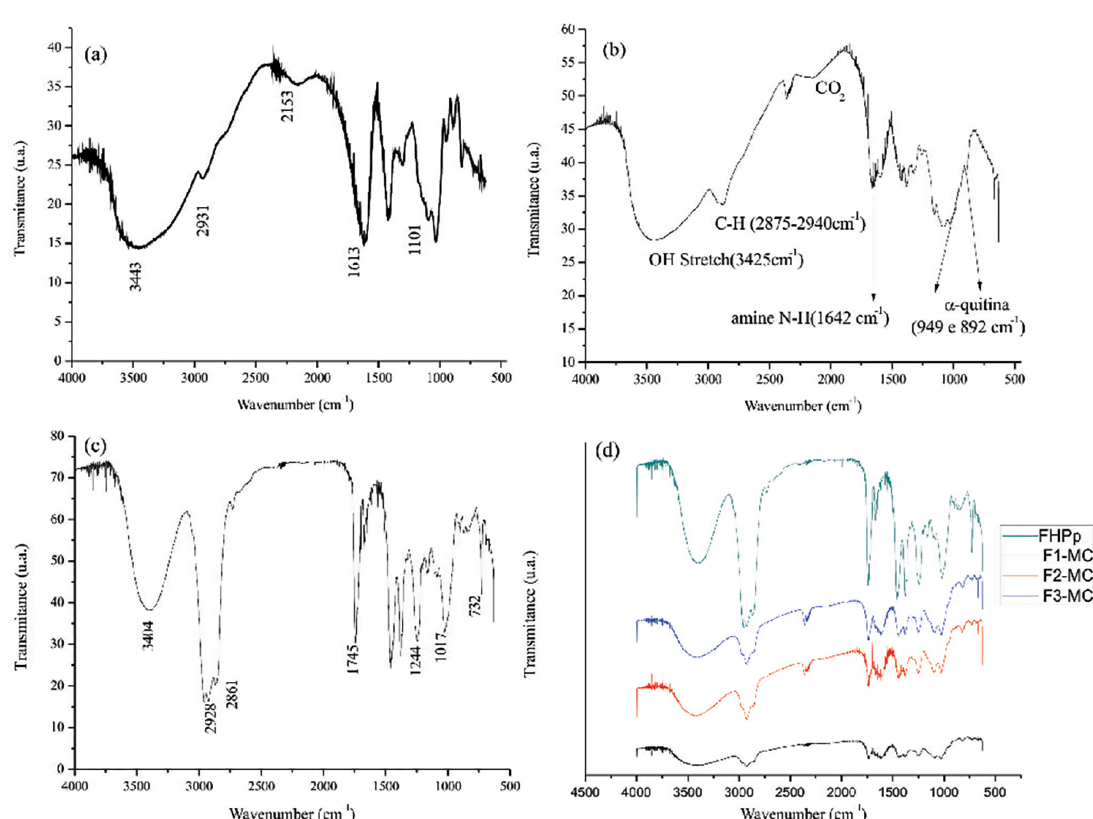
FIGURE 5 - FT-IR of alginate (a), of low molecular weight chitosan (b), of FHPp (c) and of FHPp-loaded microcapsules